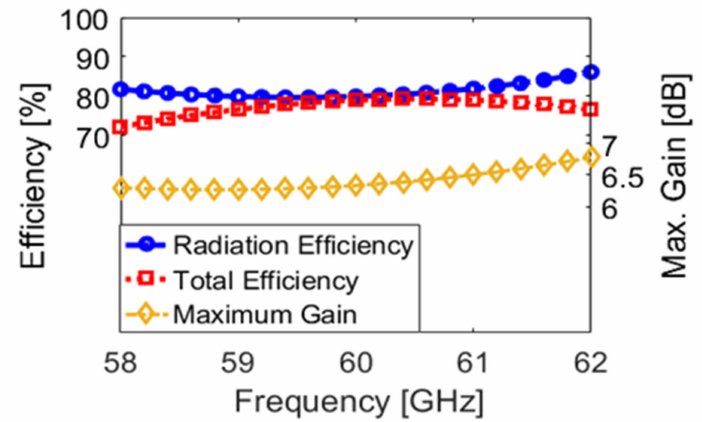
Figure 4. Antenna efficiencies and maximum gain over the operation